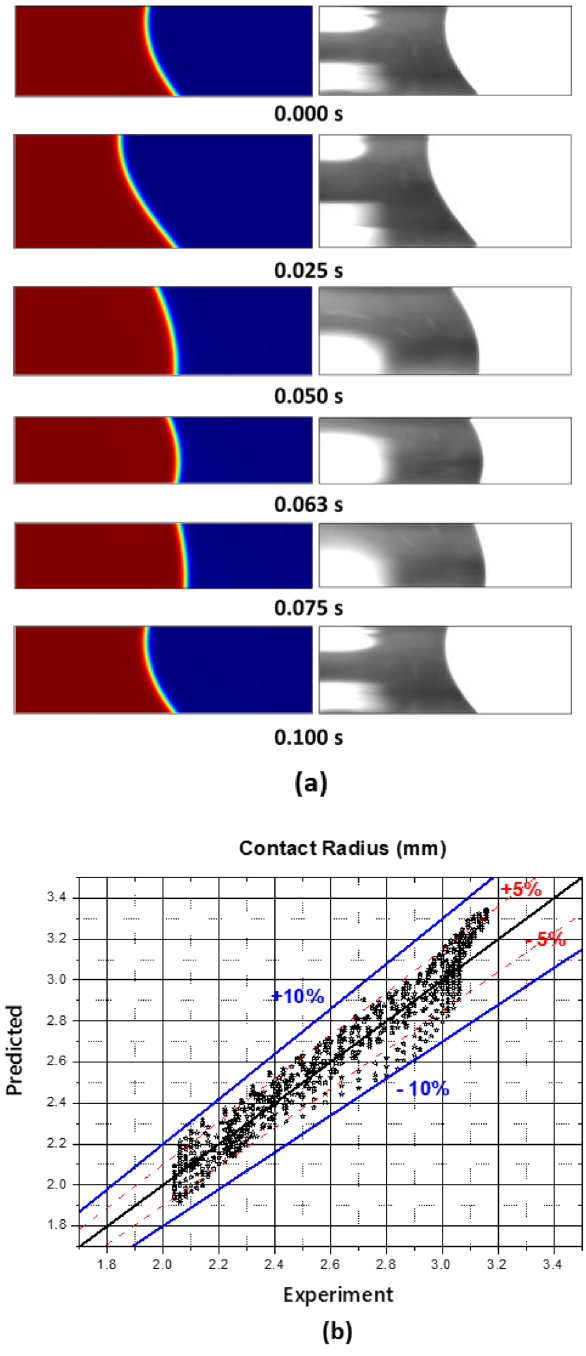
Figure 7. Comparison between the experimental result and the simulation. ( a ) Liquid deformations and ( b ) contact